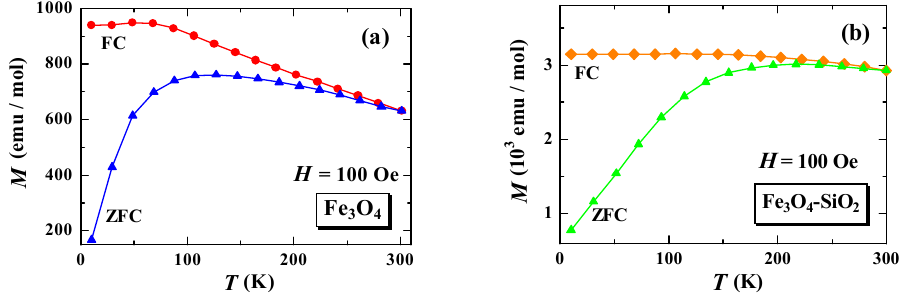
Figure 2. Temperature dependence of magnetization of Fe 3 O 4 ( a ) and Fe 3 O 4 -SiO 2 ( b ) nanoparticles.